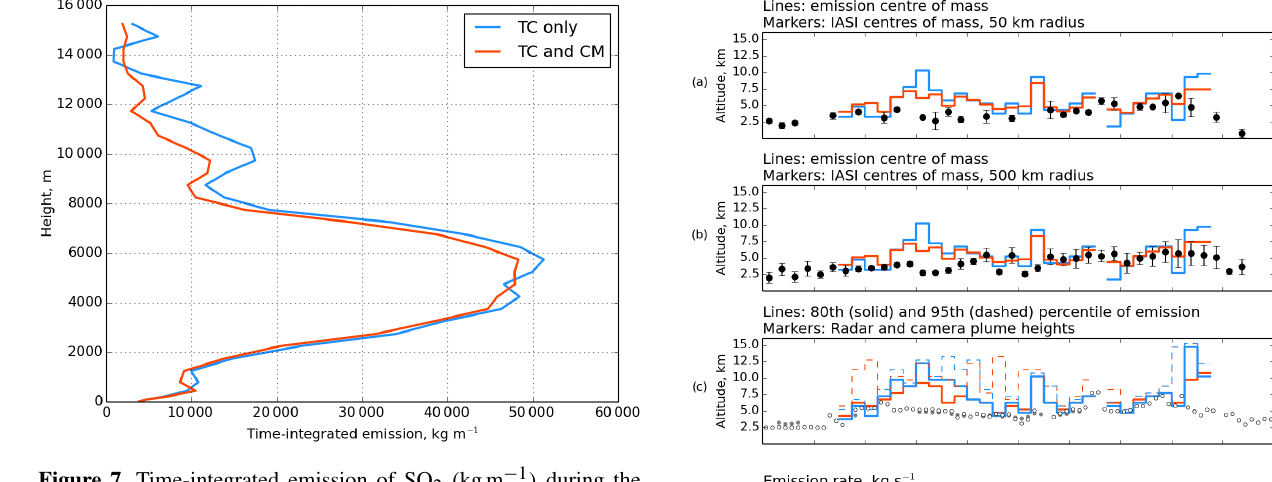
Figure 7. Time-integrated emission of SO 2 (kgm − 1 ) during the simulated period as function of height (m) for the source term in- versions with (red) and without (blue) plume height assimilation.